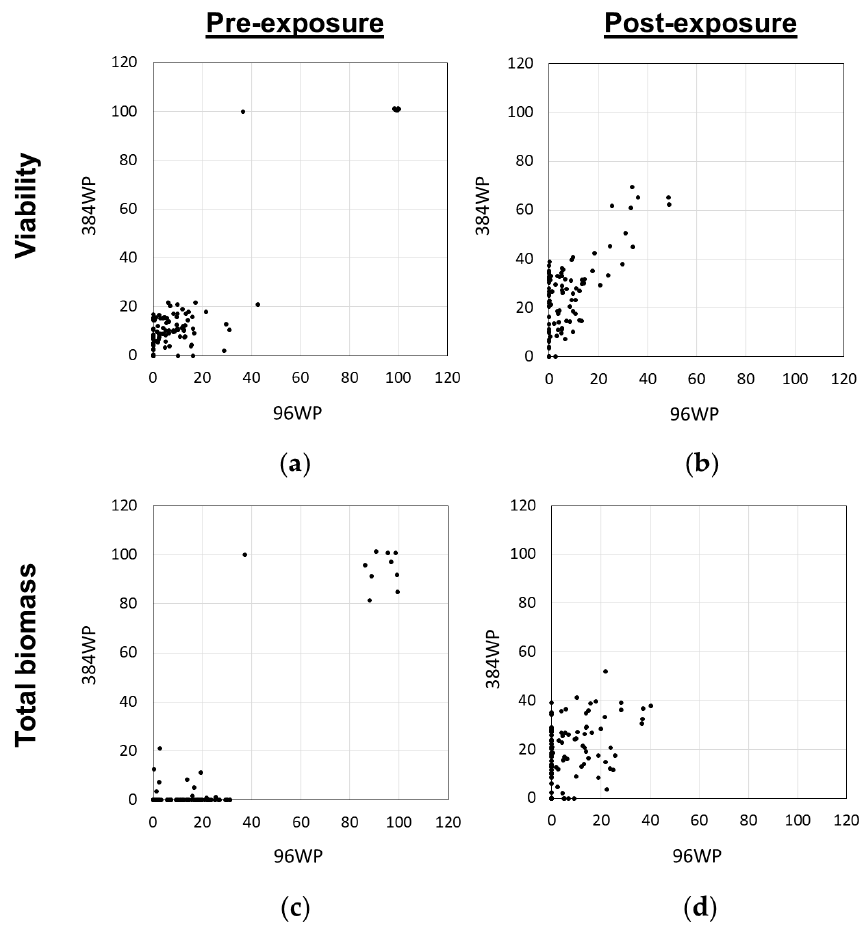
Figure 8. Inhibition of S. aureus biofilms by 100 compounds tested at 10 µ M in 96WP and 384WP in pre ( a , c ) and post-exposure ( b , d ) modes. The effect of the compounds on the biofilms was assessed by resazurin (“Viability, ( a , b )) and crystal violet (“Total biomass”, ( c , d )) staining. Results are expressed as inhibition percentages of viability or biomass in comparison to untreated biofilms and they are based on two independent biological replica experiments, with one (96WP) or two (384WP) technical replicates for each condition.